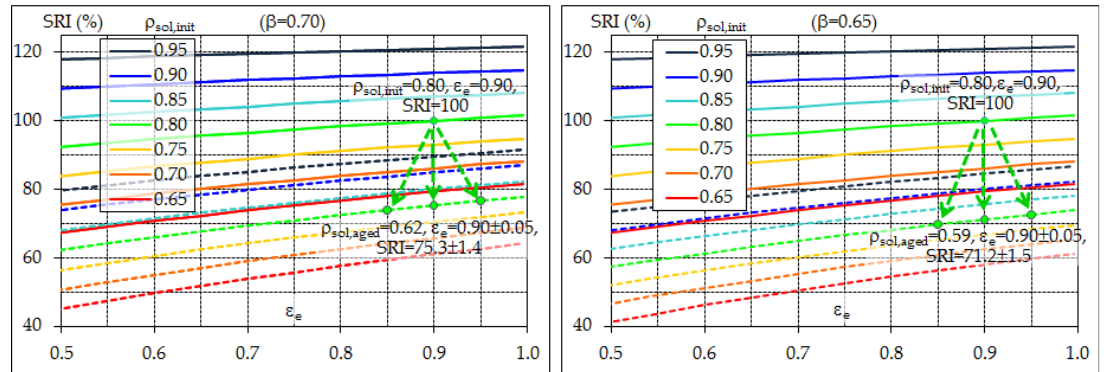
Figure 12. Initial (continuous lines) and aged (dashed lines) SRI values of highly reflective surfaces ( ρ sol,init ≥ 0.65) for intermediate wind speed (2 m/s < v wind < 6 m/s, h ce = 12 W/(m 2 K)) and (from left to right) resistance to soiling β = 0.70 and β = 0.65, with soil solar reflectance ρ sol,0 =